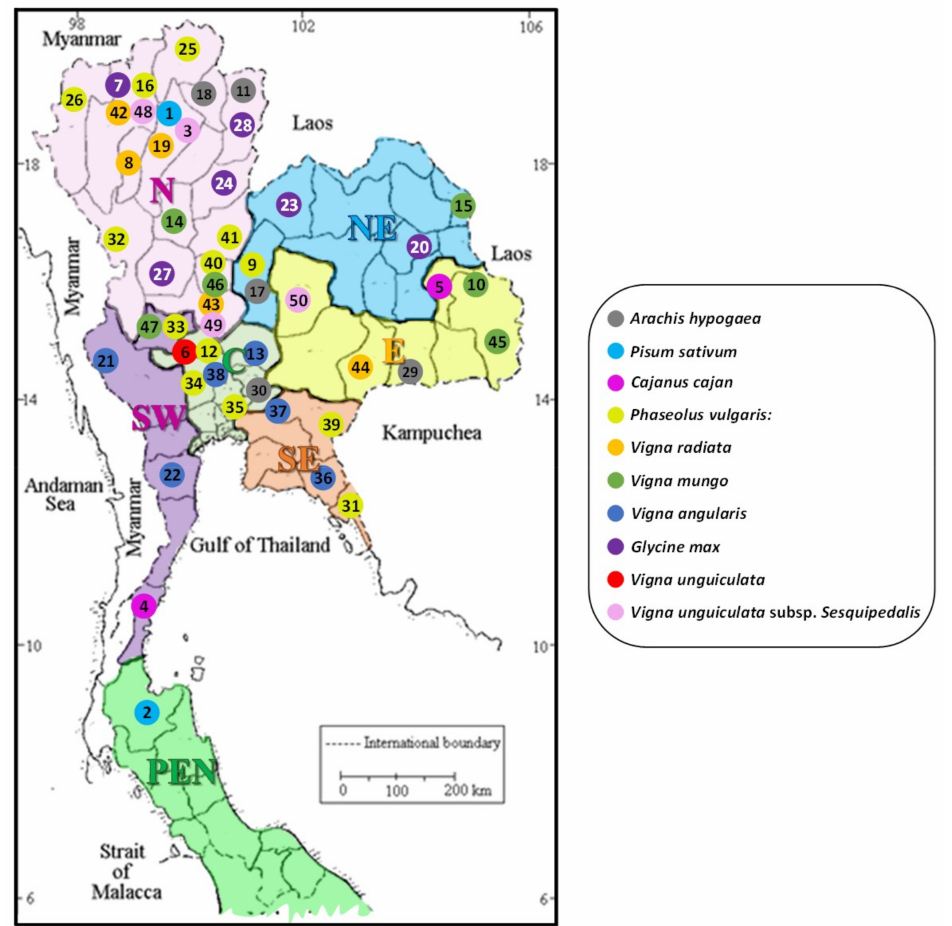
Figure 1. The distribution map of the collected 50 populations of edible seed plants (Fabaceae) throughout